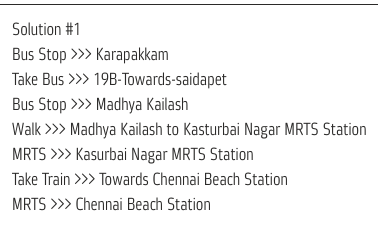
Figure 9. Program output for sample query: real-time case